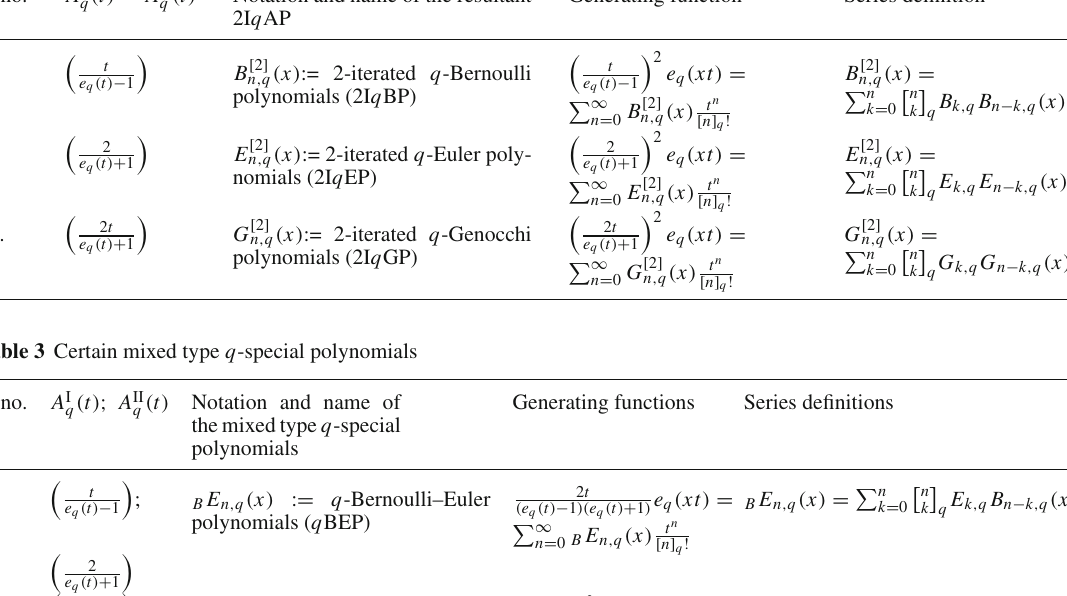
Notation and name of the resultant 2I q AP